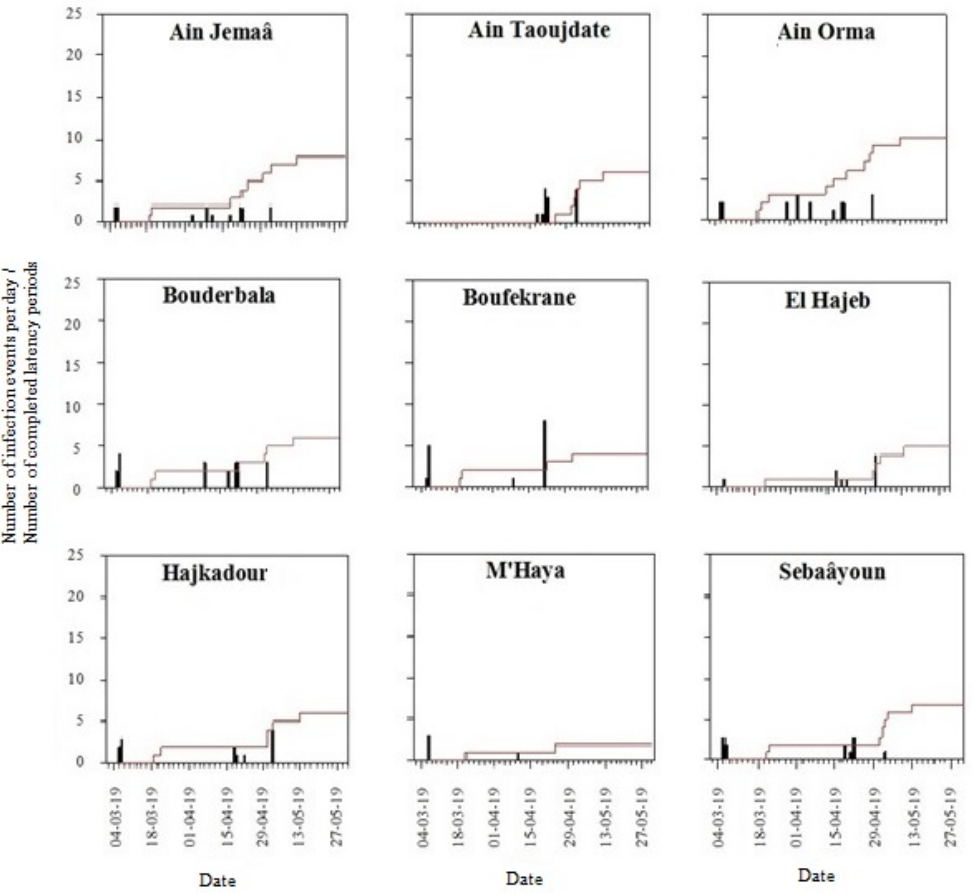
Figure 7. Simulated infection events per day (bars) and number of completed latency periods (lines) during March–May 2019. Observed data for the sites Bouderbala, Boufekrane, Hajkadour, M’Haya, and Sebaâyoun were used in the model evaluation #2 phase.